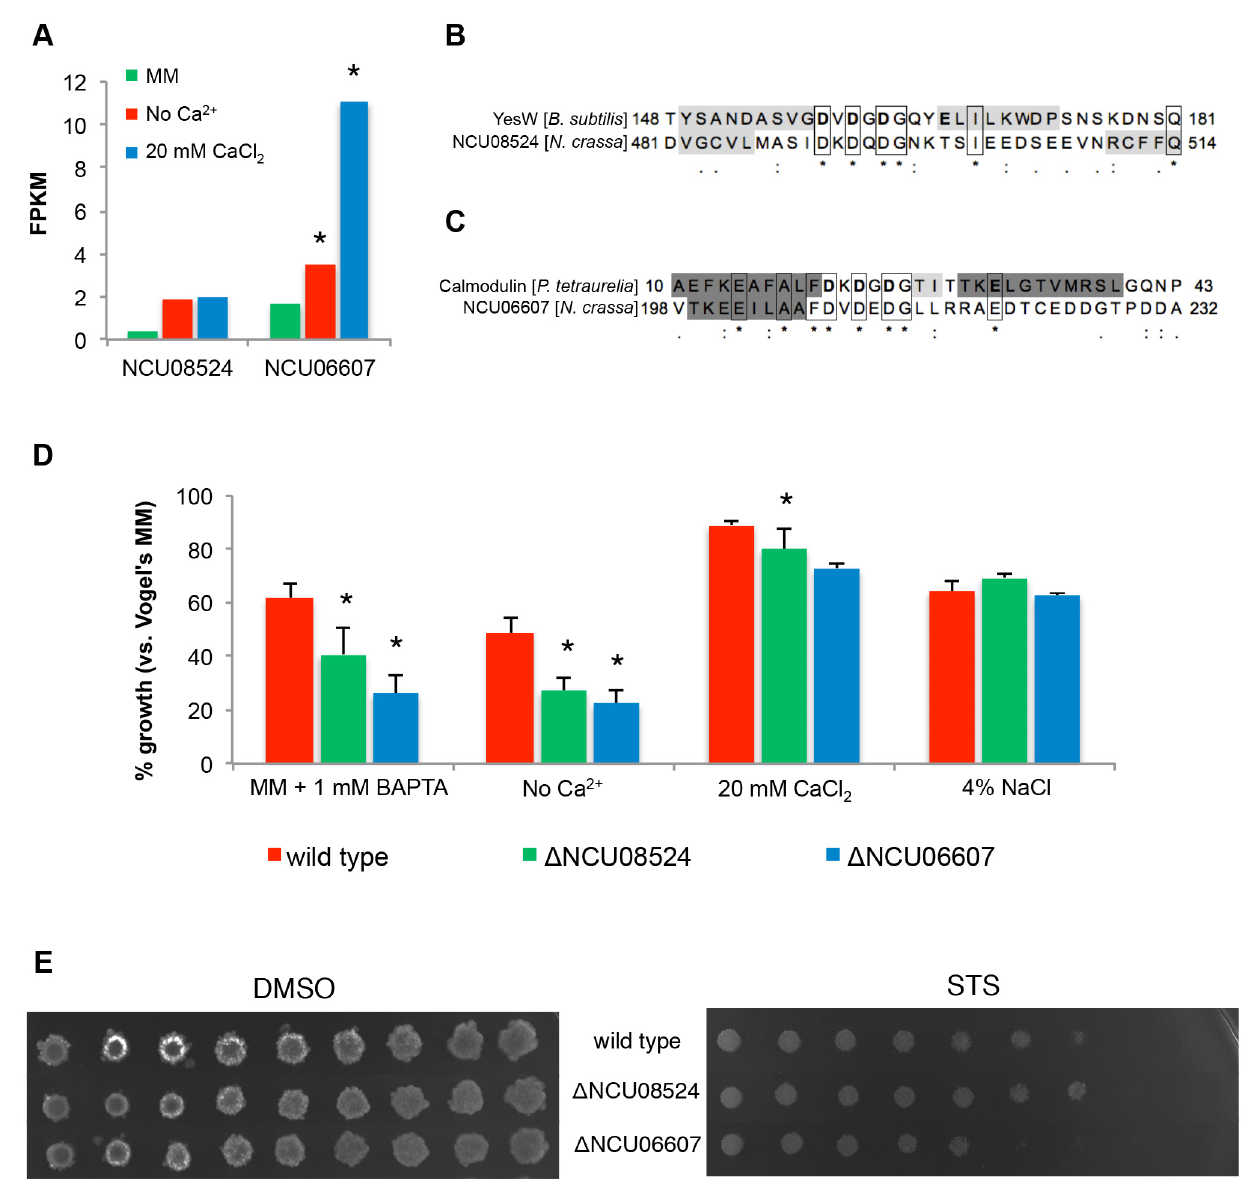
FIGURE 6: Identification of putative novel Ca 2+ -binding proteins. (A) Expression levels of NCU08524 and NCU06607 in no Ca 2+ , standard MM and 20 mM CaCl 2 media. *, p-value ≤ 0.05. (B-C) Sequence alignments of the EF-hand-like domain of NCU08524 and YesW from B. subtilis (accession number: O31526; PDB code: 2z8r) (B), and NCU06607 and calmodulin from P. tetraurelia (accession number: P07463; PDB code: 1exr) (C) . Residues binding Ca 2+ in YesW and calmodulin are in bold; β-strands and α-helices are shaded in light and dark grey, respectively (confirmed by crystallography for YesW [61] and calmodulin [62] and predicted with MEMSAT3 for NCU08524 and NCU06607). (D) The per- centages of growth of the different strains in the indicated media versus standard MM were determined by measuring absorbance of the respective liquid cultures at 450 nm. *, p-value ≤ 0.05. (E) The spot assay was used to examine the sensitivity of ΔNCU08524 and ΔNCU06607 to 5 μM staurosporine